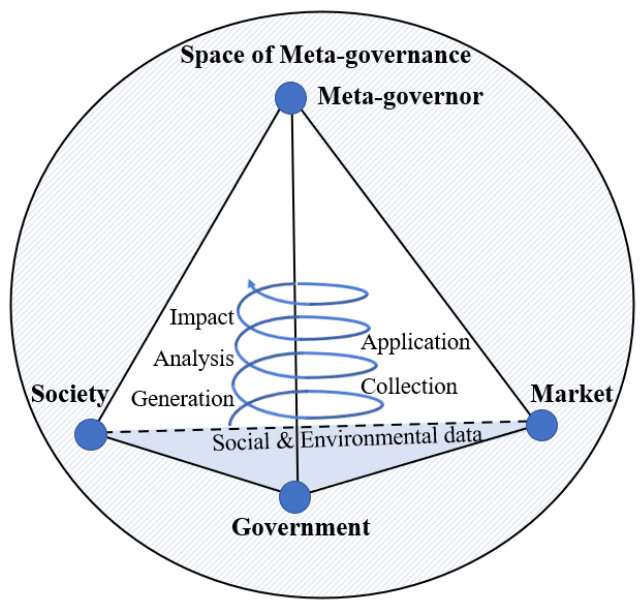
Figure 1. Meta-governance-based analytical framework for digitalization-driven agriculture transformation.